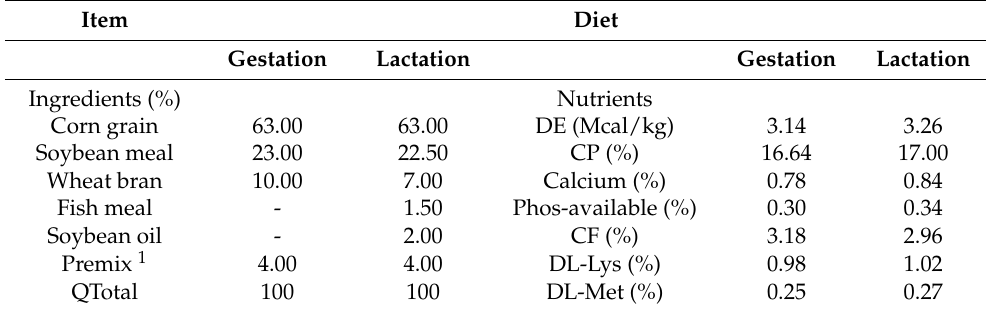
Table 1. Ingredients and formulated dietary nutrients (as-fed basis,